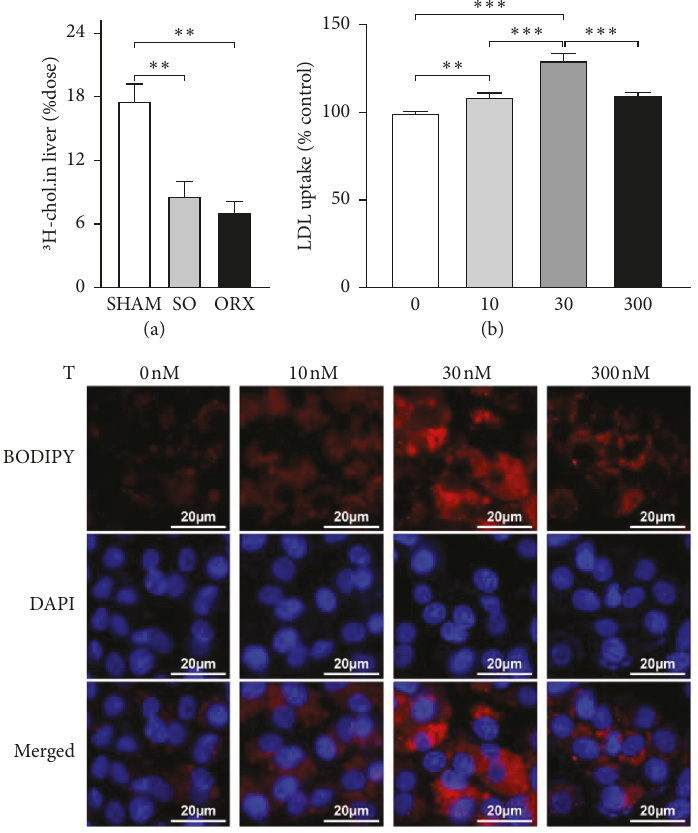
Figure 3: Testosterone deficiency attenuates cholesterol liver uptake. (a) Amount of 3H-cholesterol in the liver of rats 2 hours after the gavage with 5 Ci 3H-cholesterol and 0.1mg unlabeled cholesterol demonstrating the liver cholesterol uptake ( n of HepG2 cells in different levels of testosterone. Cells were incubated with 0, 10, 30, 300 nM testosterone for 72h and then BODIPY-labeled low-density lipoprotein (LDL) (red) for 2h. After wash of PBS for twice, cells were stained with DAPI (blue) and visualized using confocal μ microscopy. Data are presented as mean SEM. Statistical analyses are unpaired t -test or one-way ANOVA. P 0 . 001; ns: ± <